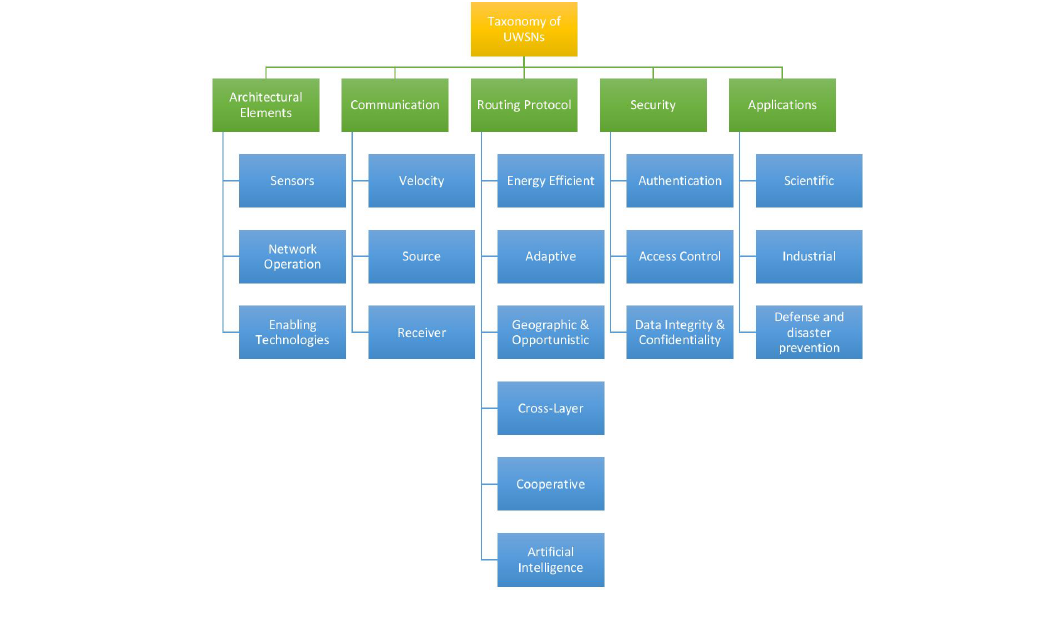
Figure 5. A Thematic Taxonomy of